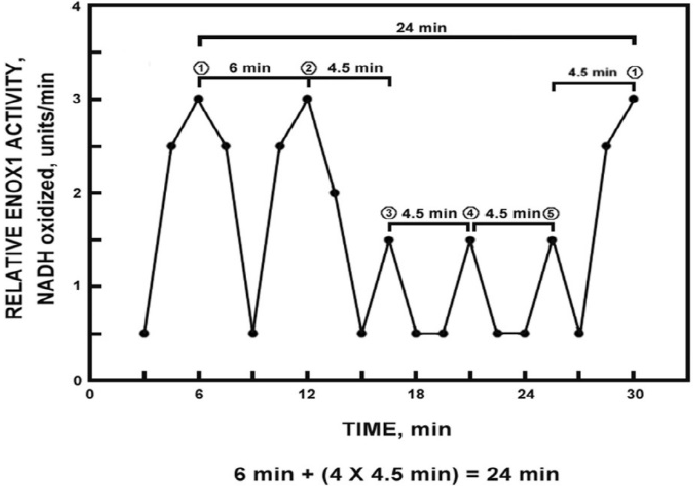
Figure 1. Diagrammatic representation of the signature ENOX cycle with measurements averaged over 1 min at intervals of 1.5 min. Typically there are five maxima, two of which ① and ② are separated by 6 min and three of which ③ , ④ and ⑤ are separated from each other and from ① and ② by 4.5 min. The asymmetry defines a 24 min period (6 min + (4 × 4.5 min)). Reproduced from [4] with permission from Springer Science + Business